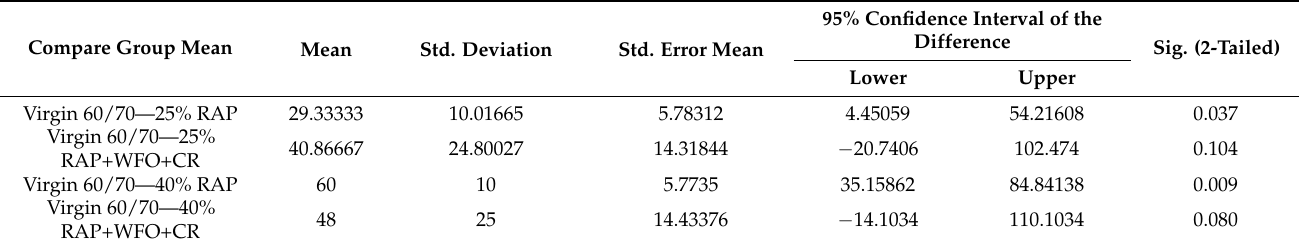
Table 10. Comparison of significant difference of group means for the ductility result.